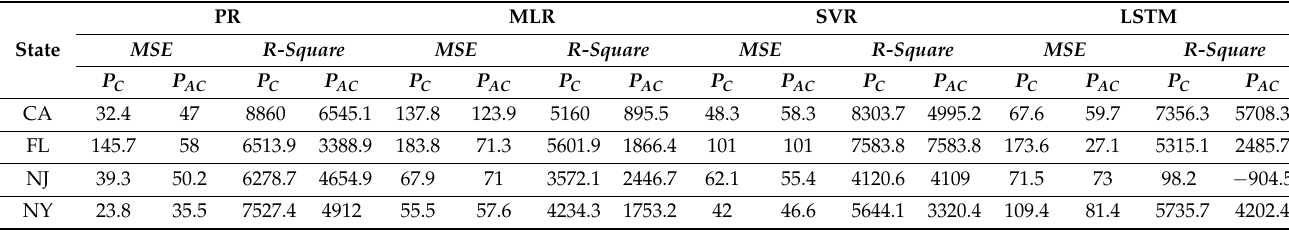
Table 4. Evaluation of different predication